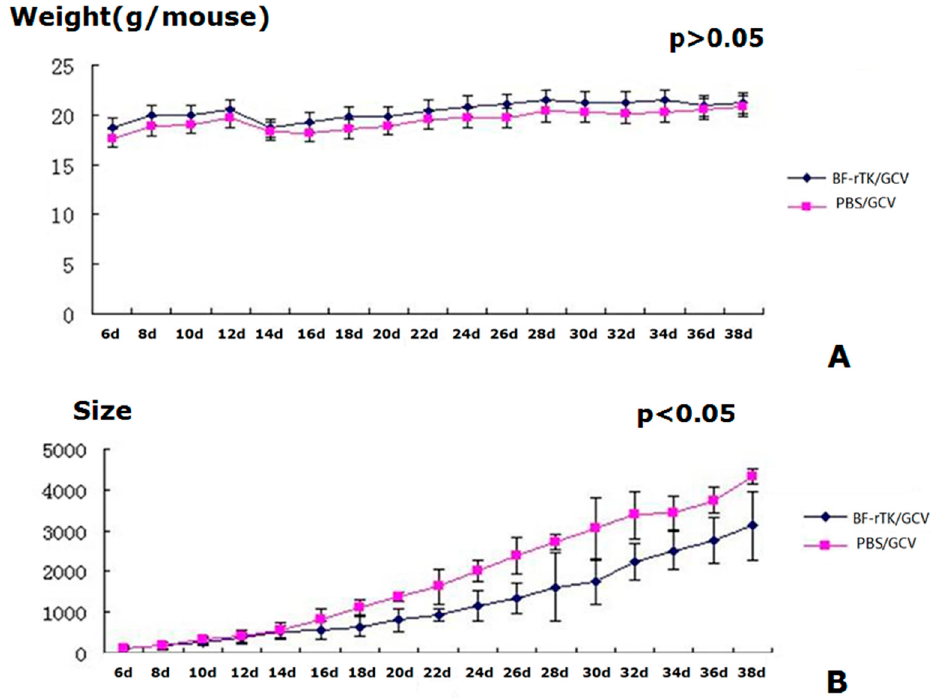
Figure 5. BF-rTK/GCV treatment significantly inhibits tumor growth in vivo . ( A ) Body weight curve of nude mice treated by BF-rTK/GCV or PBS/GCV ( p > 0.05; n = 5); ( B ) Tumor growth of nude mice treated by BF-rTK/GCV or PBS/GCV ( p < 0.05; n = 5). The tumor size was calculated as follows: V = 1/2AB 2 (V: tumor size, A: tumor long diameter, B: tumor short